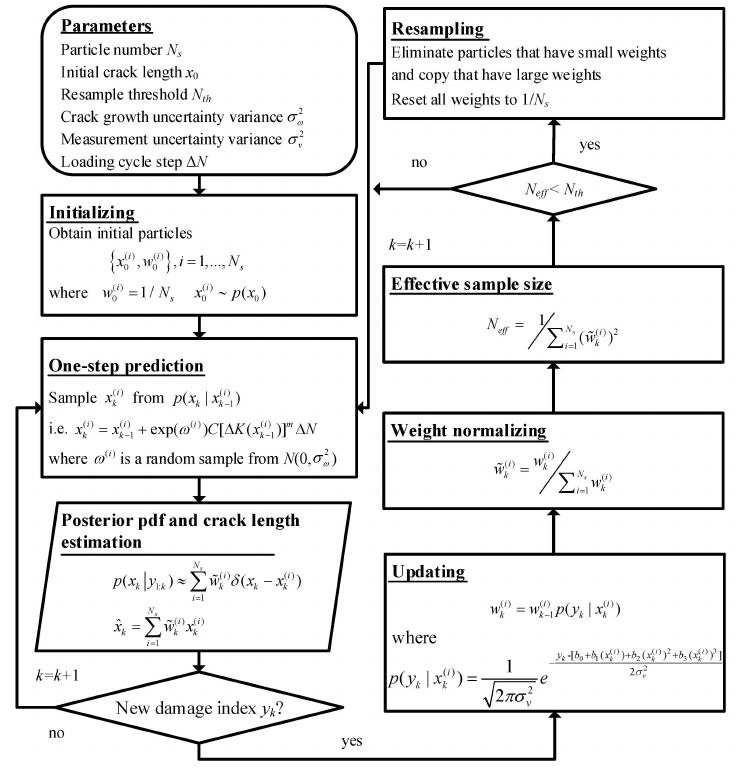
Figure 4. Flow chart for estimating the crack length posterior pdf with the